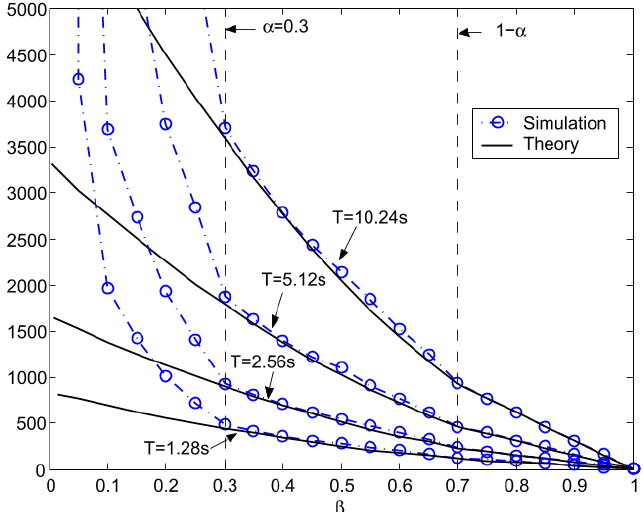
Figure 21. Average latency comparison with varied scanning duty ratio ( β ) and a fixed advertising duty ratio ( α = 0.3). Adapted from